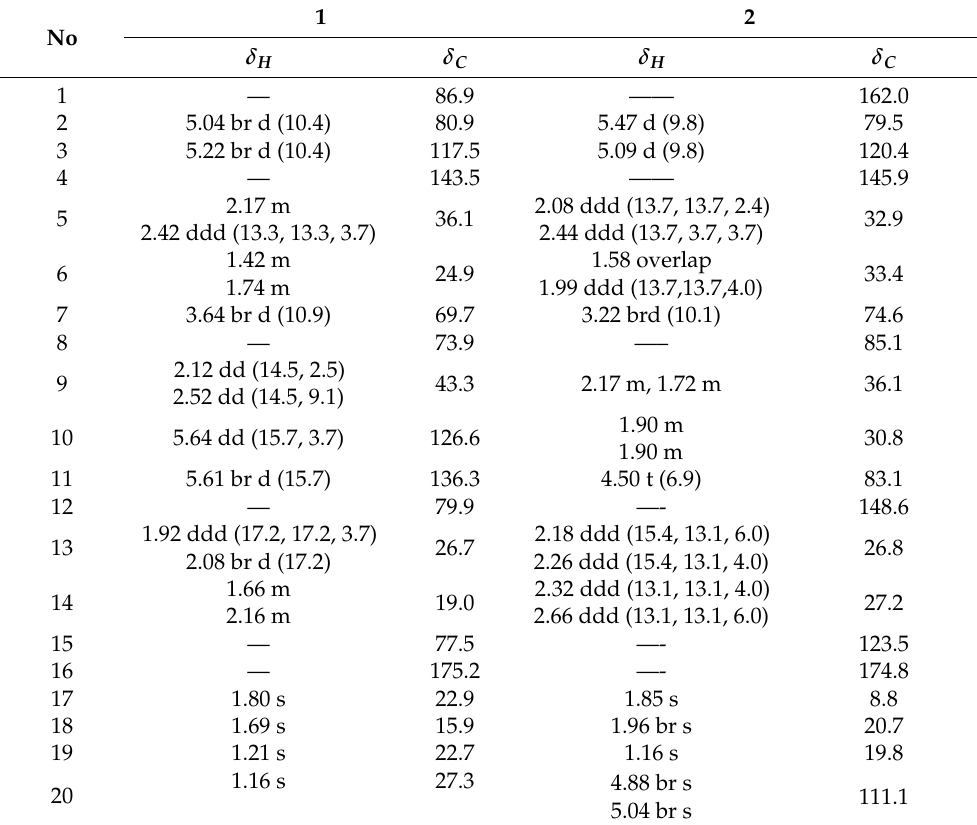
Table 1. 1 H and 13 C NMR data of compounds 1 and 2 in CDCl 3 (500 and 125 MHz δ in ppm, J in Hz).